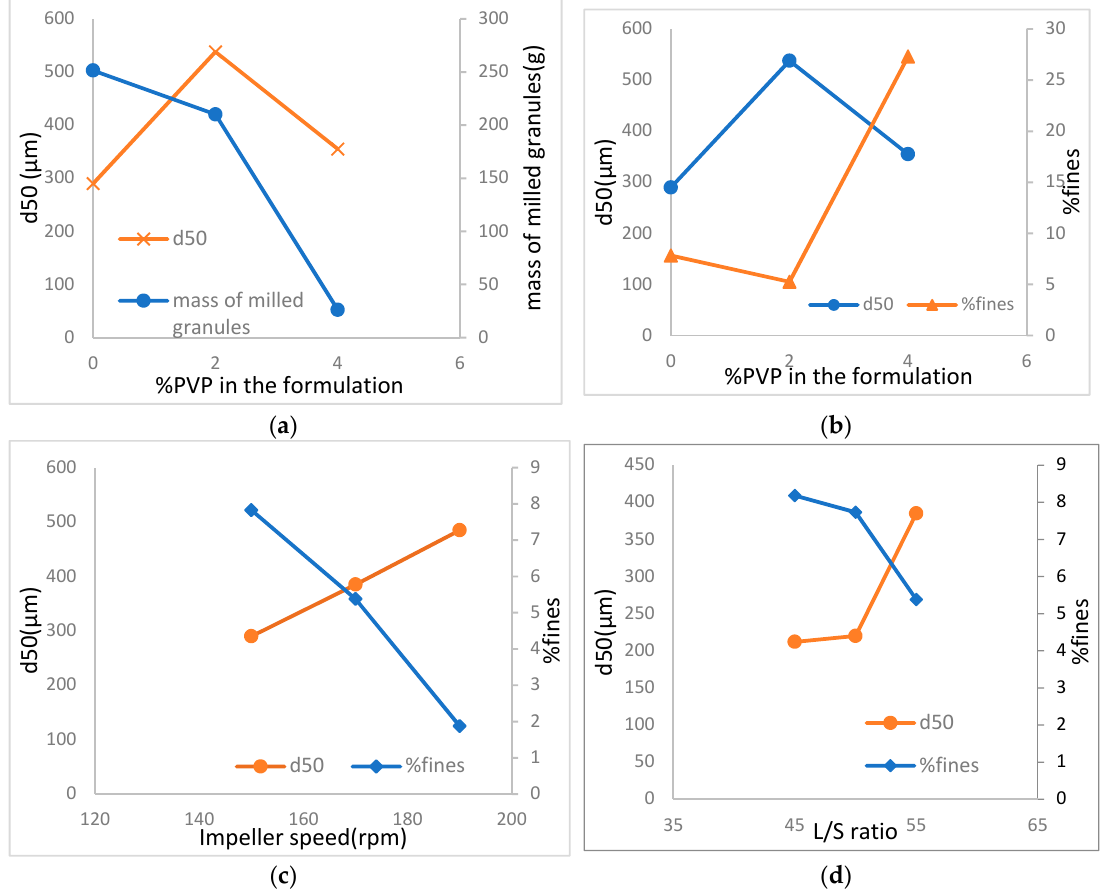
Figure 13. ( a ) Plot showing the effect of %PVP on d50 & mass of milled granules, ( b ) effect of %PVP on d50 and %fines, ( c ) effect of impeller speed on d50 and %fines, ( d ) effect of L/S ratio on d50 and %fines.